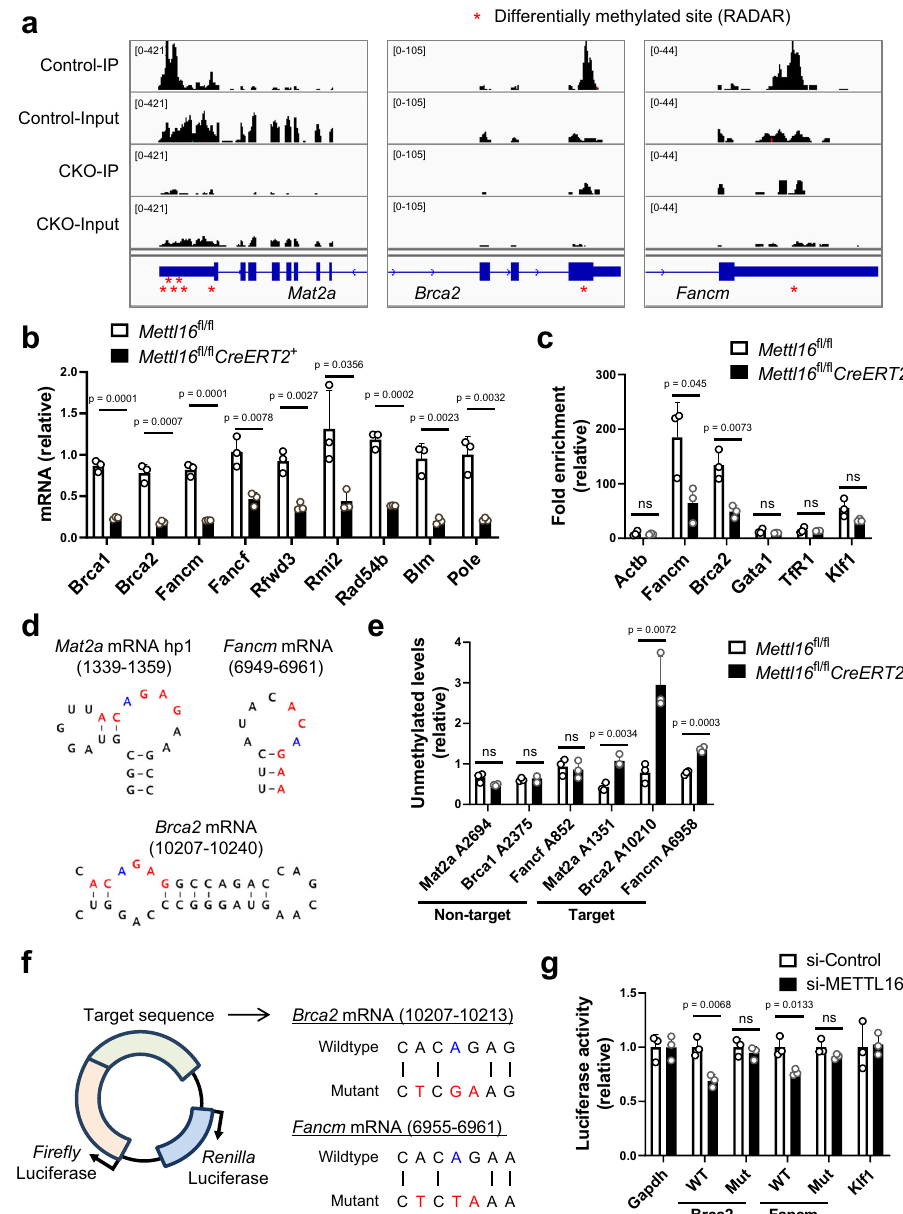
Fig. 5 | Identi fi cation of METTL16-regulated motifs in DNA-repair-related transcripts. a IGV snapshots of MeRIP-seq reads along indicated mRNAs. Red asterisk indicates differentially methylated sites identi fi ed by RADAR. b , c mRNA expression levels ( b ) and MeRIP-qPCR validation of m 6 A methylation levels ( c ) in the E13.5 in vitro cultured erythroblasts from control and Mettl16 fl / fl CreERT2 + (CKO) mice ( n =3 biological replicates). d Predicted secondary structures sur- rounding m 6 A peaks in Mat2a , Brca2 , and Fancm mRNA. The ACAGAR boxes were shown in red and the m 6 A modi fi cation sites were shown in blue. e SELECT vali- dation of the indicated m 6 A sites using total RNAs of the E13.5 cultured erythro- blasts from control and Mettl16 fl / fl CreERT2 + mice ( n =3 biological